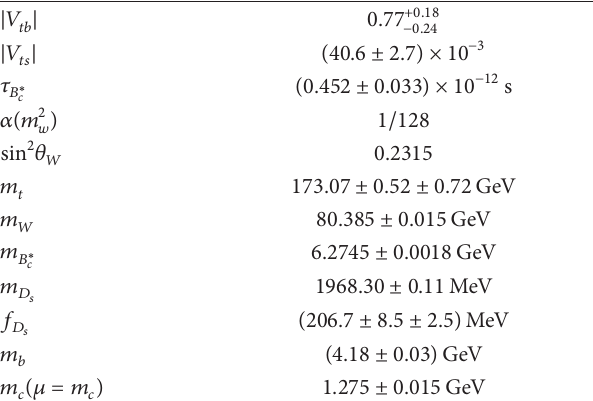
Table 2: Parameters appearing in the form factors of the 𝐵 ∗ 𝑐 → ]] decayinafour-parameterfit,for 𝑀 2 𝐷 𝑠